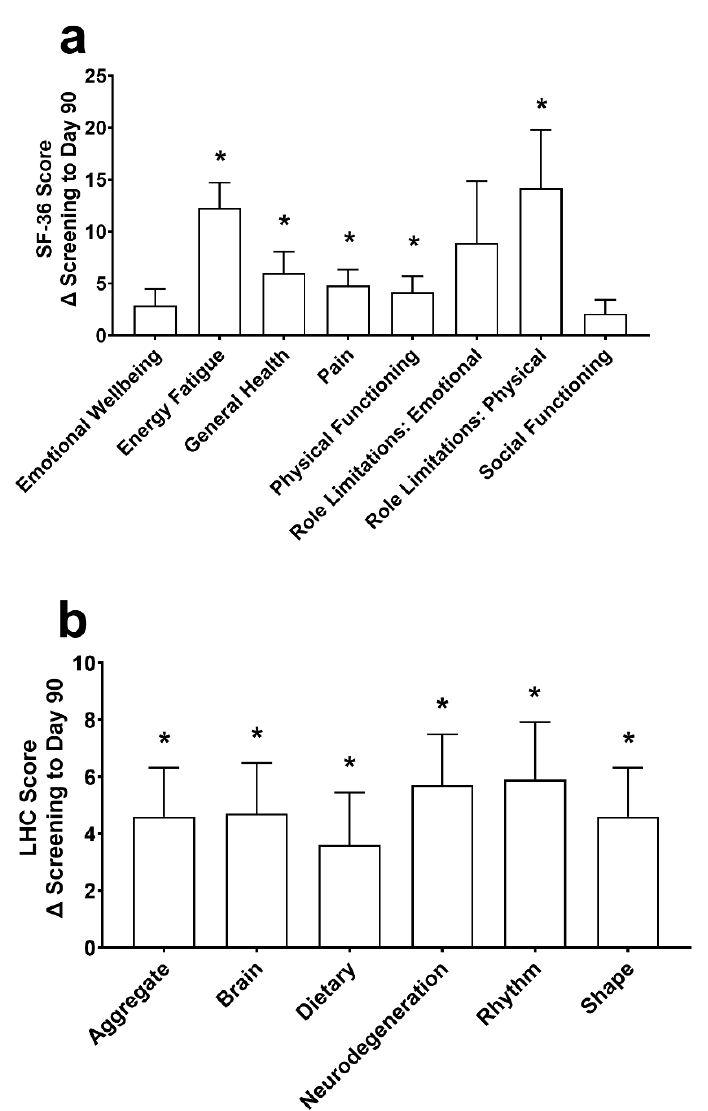
Figure 4. The change ( ∆ ) in the 36-Item Short Form Survey (SF-36; ( a )) and the Life Habits Checklist (LHC; ( b )) from screening to Day 90. Data are mean ± standard error of the mean. SF-36 and LHC were assessed using a repeated measures mixed effects model with visit number as the fixed effect and participant as the random effect. * Significantly different from screening at Day 90 ( p < 0.05).